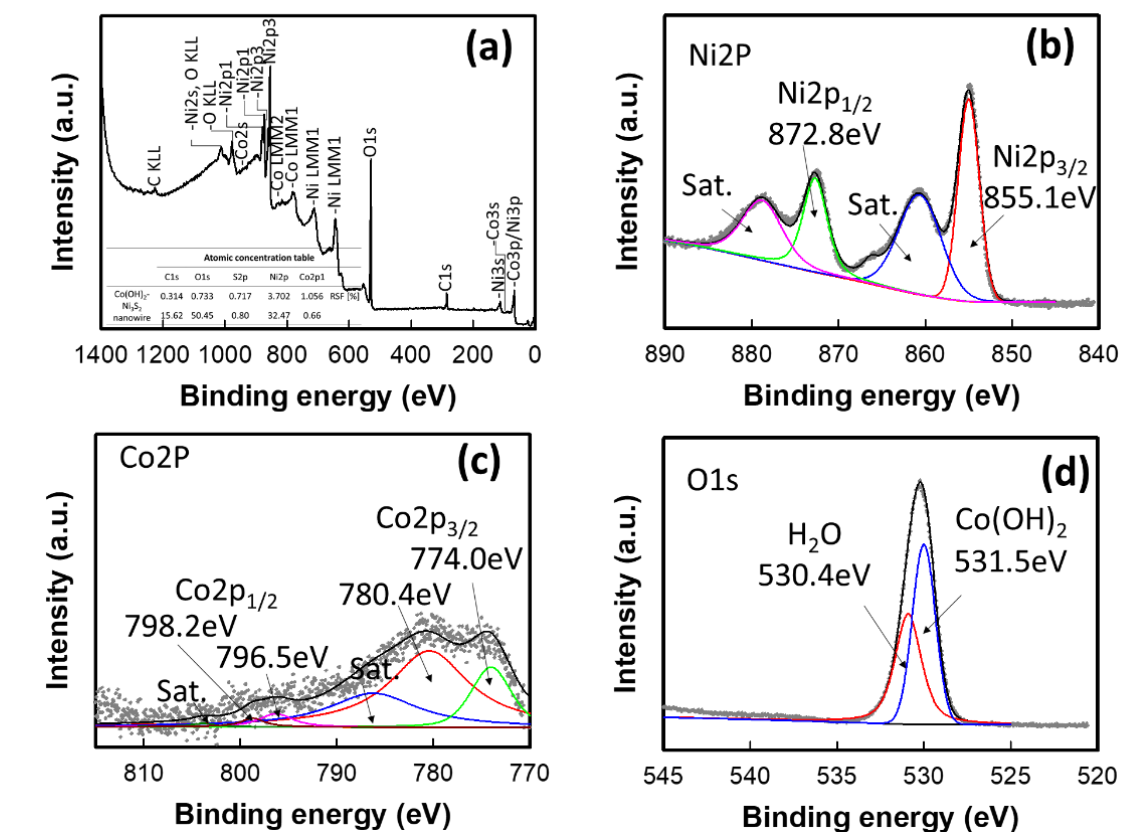
Figure 5. XPS spectra of the Co 0.5 –Ni 3 S 2 electrode. ( a ) Survey, ( b ) Ni 2p, ( c ) Co 2p, and ( d ) O 1s electron XPS spectra.